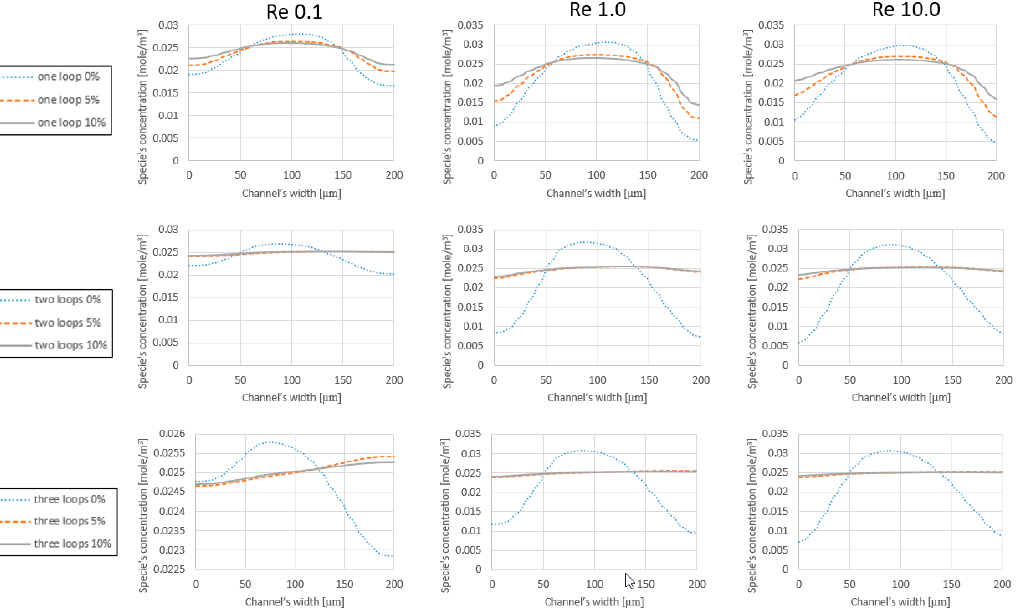
Figure 5. Species concentration along the outlet’s cross section. At each row, a specific class of the mixers is represented and at each column the concentration distribution of species at the outlets, regarding the operating conditions.